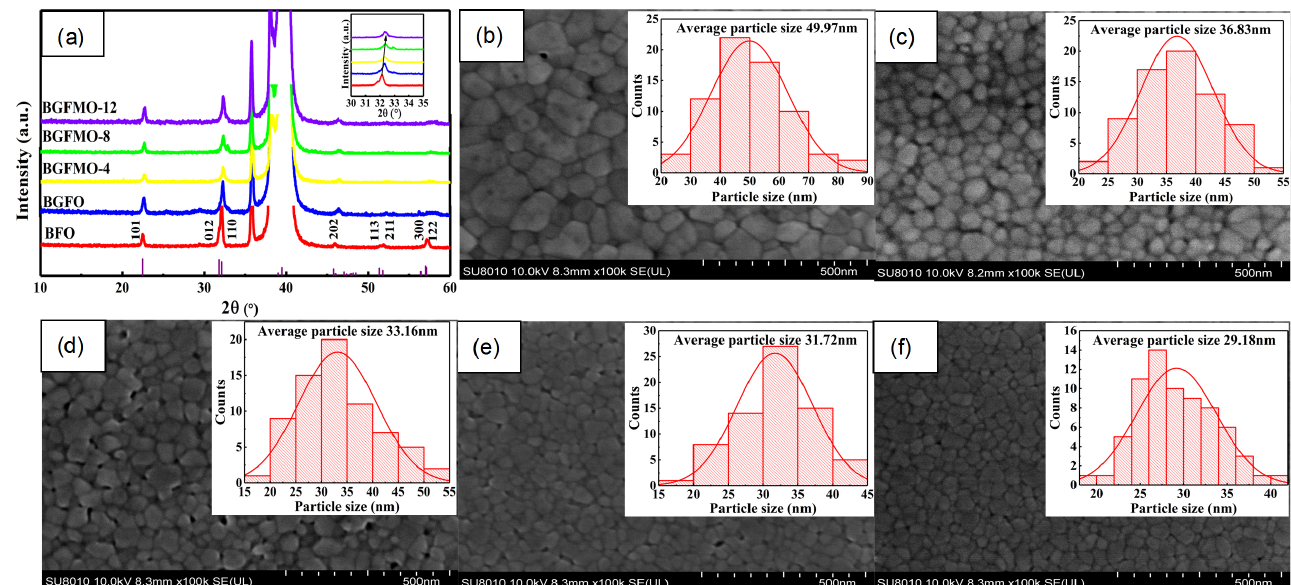
Figure 1. ( a ) XRD spectrum from BFO to BGFMO-12. The inset shows the redshift peak of (012) and (110). ( b – f ) SEM micrographs of ( b ) BFO, ( c ) BGFO, ( d ) BGFMO-4, ( e ) BGFMO-8 and ( f ) BGFMO-12 films. The insets: Histograms of particle size distribution of different